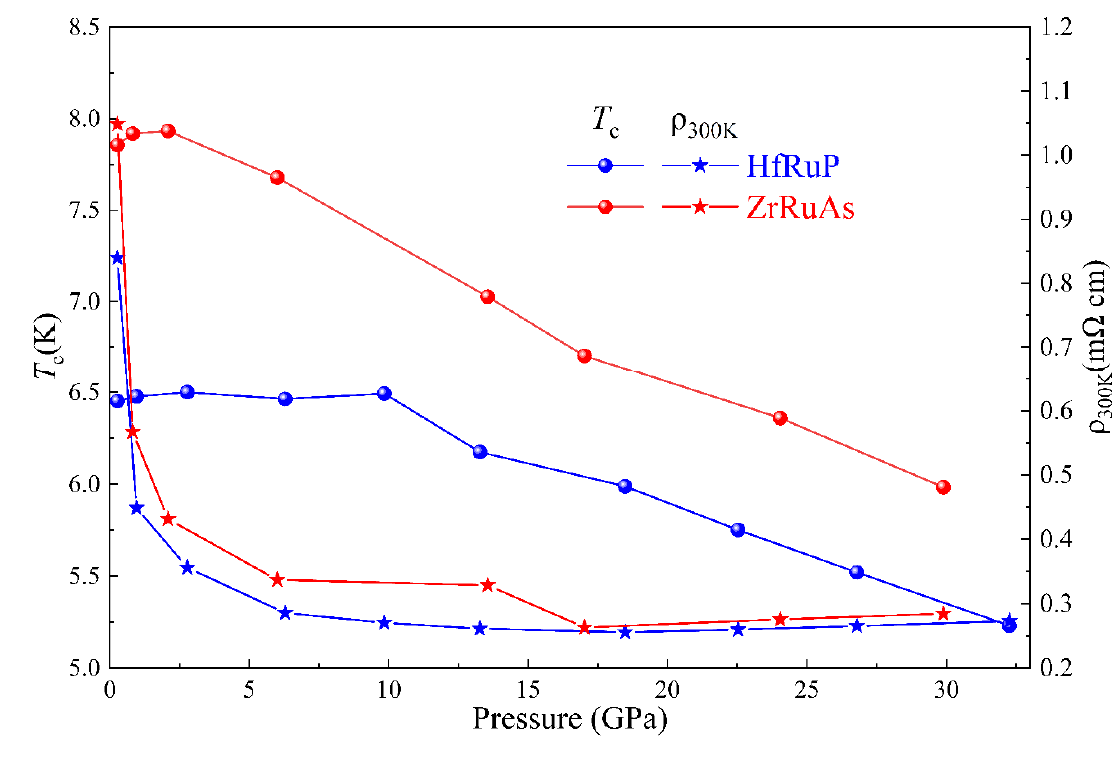
Figure 4. The pressure dependence of T c s and resistivity at 300 K of ZrRuAs and HfRuP.